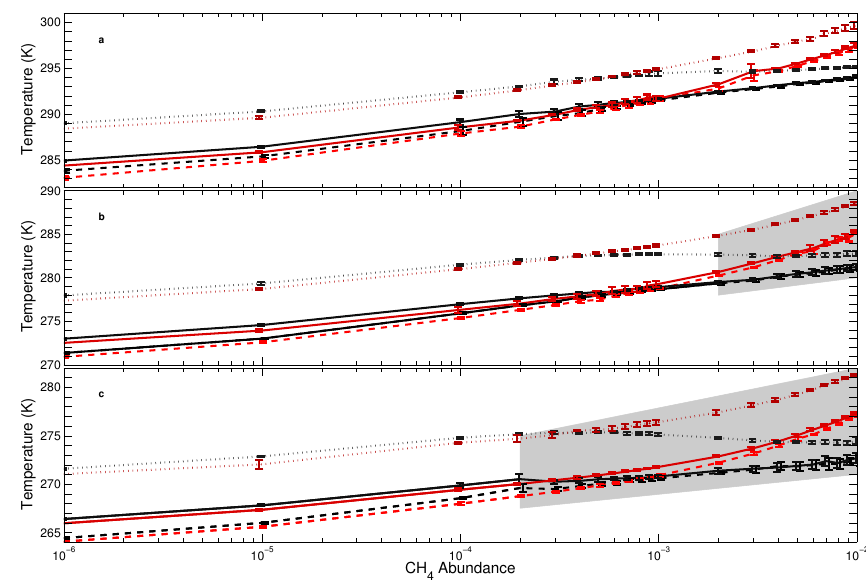
Figure 4. Surface temperature as a function of CH 4 . The three panels correspond to CO 2 abundances of (a) 10 − 1 , (b) 10 − 2 , and (c) 10 − 3 . Dashed lines are for the low-H 2 O parametrization, solid lines are for the mid-H 2 O parametrization, and dotted lines are for the high-H 2 O parametrization. Black lines are for the HITRAN 2012 database and red lines are for the HITRAN 2000 database. Shaded regions indicate the possibility of an organic haze. Error bars are plotted corresponding to the error estimates from Sect. 3.2.